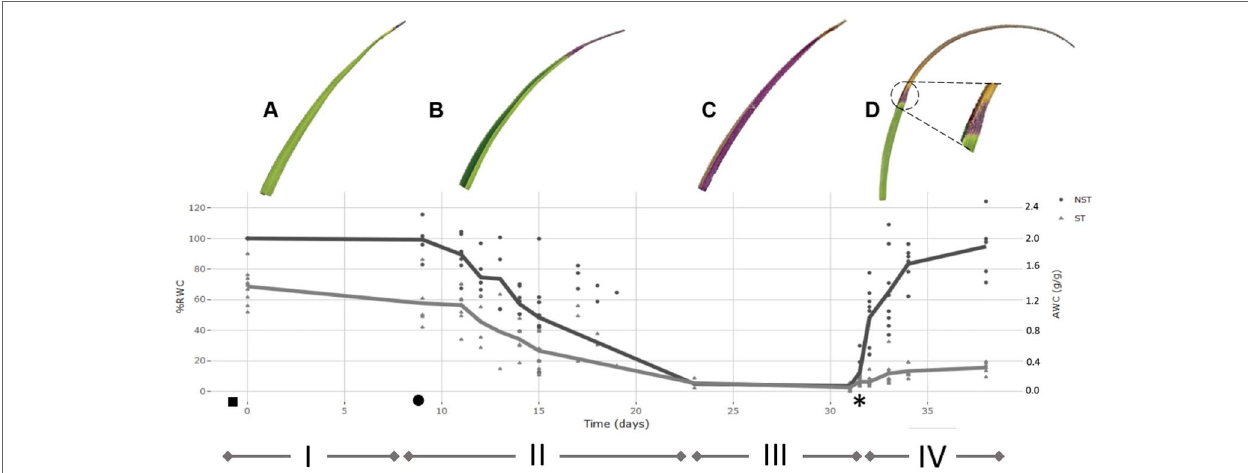
FigURe 2 | Desiccation-rehydration curve for the drying of Xerophyta schlechteri . The % relative water content (RWC) for 10 individuals was determined at daily intervals from the onset of water loss until the air-dry state was reached. The mean %RWC for each time point was used to plot the model dehydration curve. The model dehydration curve for both tissue types is shown [non-senescent tissues (NST) and ST]. All calculated values were set relative to the absolute water content of the NST at day 0 (100% RWC). The curve is divided into four distinct phases: i) fully hydrated; ii) slow dehydration of all tissues; iii) air-dry desiccated state; iv) rehydration after addition of water. The initial watering took place at dusk before day 0 (indicated with a ◻ ) and the first sampling at 1 h after dawn on day 0. When the soil moisture content was recorded as 0.01g H 2 0/g( ◻ ), sampling for the desiccation phase was initiated. Plants were left in the dry state for one week, followed by rewatering at day 31 (*). High resolution scans of X. schlechteri leaves accompany each phase to illustrate physiological changes occurring in the leaf tissue, and to illustrate differential responses between the two tissue types. A represents FT, B represents 60% RWC in NST, C represents AD, D represents 72 h following rehydration. Triangle points are representative of ST and closed circles represent